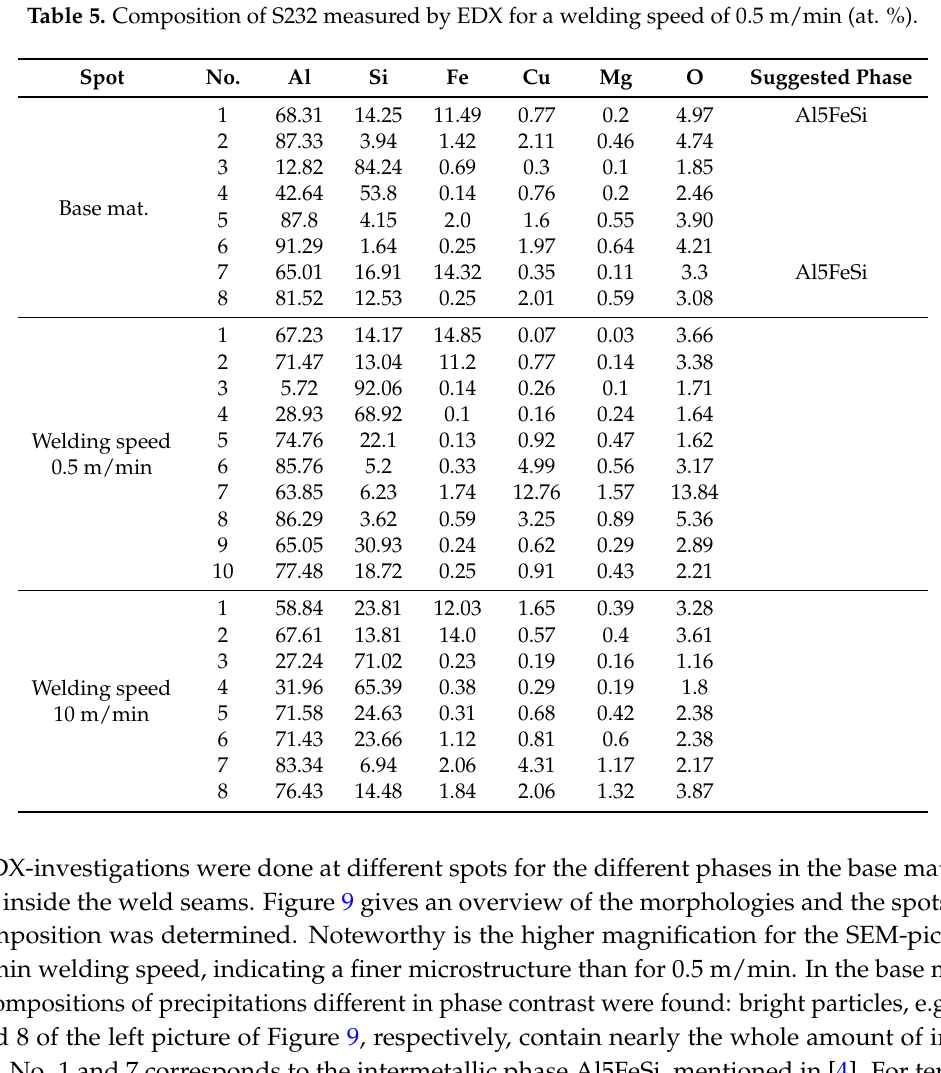
Table 5. Composition of S232 measured by EDX for a welding speed of 0.5 m/min (at. %). Spot No. Al Si Fe Cu Mg O Suggested Phase